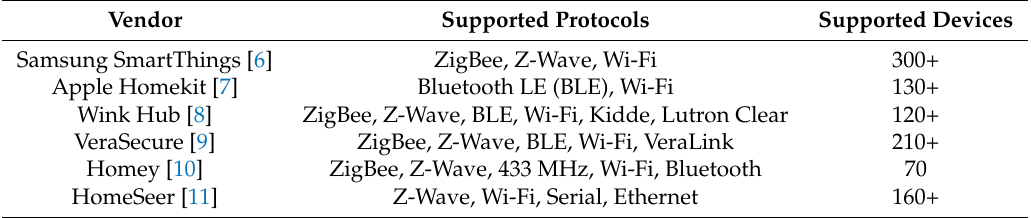
Table 1. Commercial Gateway